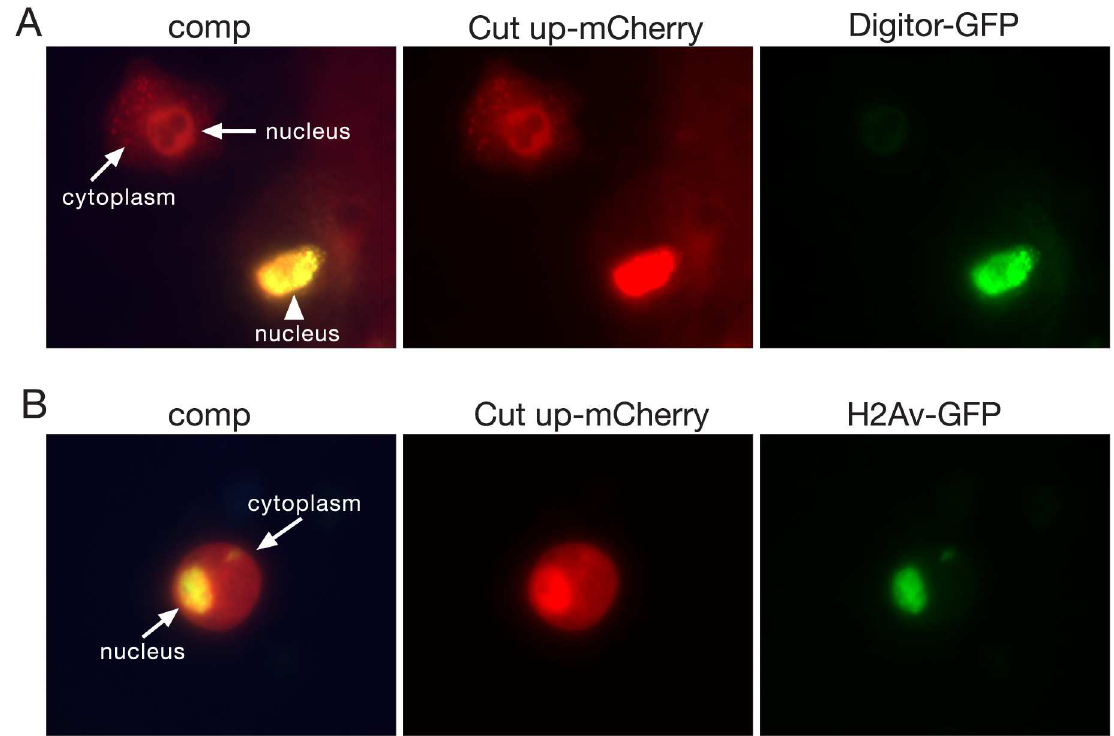
Fig 3. Live imaging of transiently transfected S2 cells with Digitor-GFP and Cut up-mCherry. (A) Co-transfection of Cut up-mCherry together with Digitor-GFP. Cut up-mCherry in singly transfected cells was localizedboth to the nucleusand the cytoplasm (arrows); however,in co-transfected cells, Cut up-mCherry was found only in the nucleustogether with Digitor-GFP (Arrowhead). (B) In cells co-transfected with Cut up-mCherry and an H2Av-GFP control construct, Cut up-mCherry retainedits dual localization to both the nucleusand cytoplasm